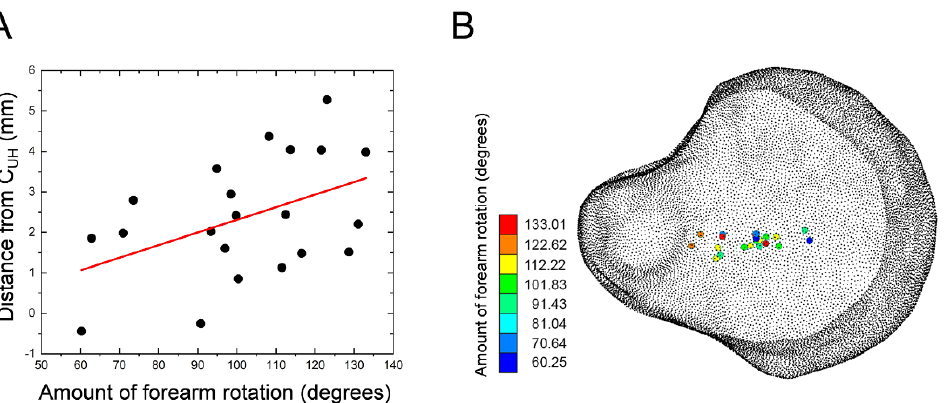
Figure 5. The location of the RC in the radioulnar direction and the amount of forearm rotation. ( A ) The position of the RC in the radioulnar direction was significantly correlated with the amount of forearm rotation (Pearson’s correlation coefficient = 0.454, p = 0.039). ( B ) The color-gradient diagram shows that the RC was located more ulnarly when the amount of forearm rotation was greater.